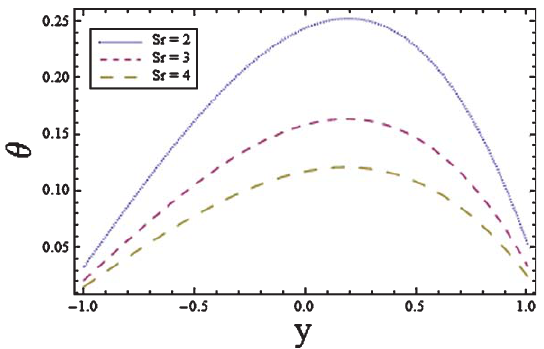
Fig. 6. Plot of the temperature θ for various values of the Soret number Sr with (cid:15) = 0 . 2, x = 0 . 1, t = 0 . 1 , Sc = 1 , Du = 2 , γ = − 1 . 5 , γ = 10 , Pr = 1 . 5 and γ = 8. 1 2